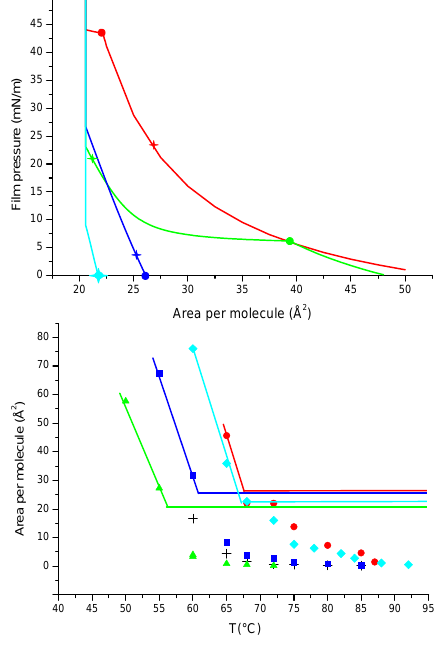
Fig. 3. (a) . π -A isotherms of lauric acid (red line), pentade- canoic acid (green line), stearic acid (blue line) and arachidic acid (turquoise line), according to the model of Seidl (2000). The crosses represent the Equilibrium spreading Pressure of an excess bulk phase of the individual fatty acids and the circles illustrate the phase transition film pressure between the expanded and condensed phases. (b) . Area per molecule of the fatty acids as a function of the evaporator temperature (black crosses: C 9 , red circles: C 12 , green triangles: C 15 , blue squares: C 18 and turquoise diamonds: C 20 ) as calculated from the particle growth measurements. The solid lines indicate the expected behavior of the true area per molecule to take into account that the monolayers cannot spontaneously get more compressed than the equilibrium spreading